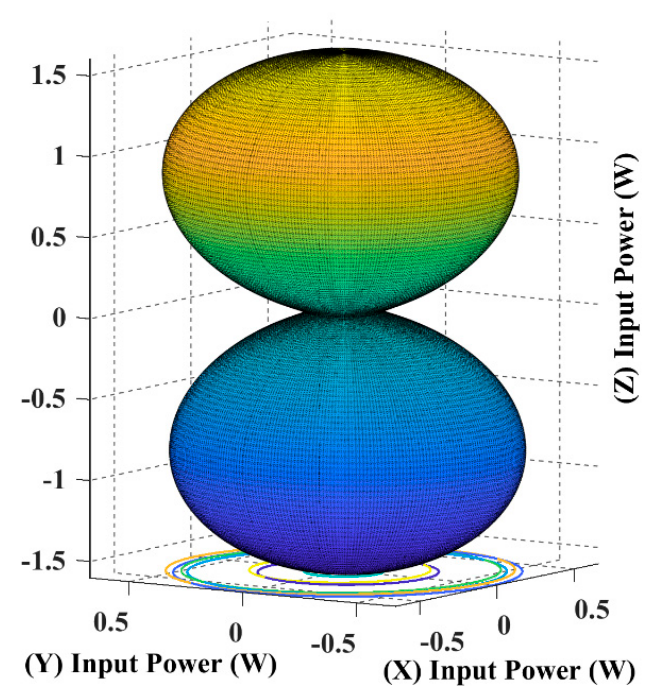
Figure 9. The input power spherical plot for the 3D WPT system when the receiver is placed at α = φ = 0°. From Figure 10, it is noticeable that when the receiver is placed at the 45 ◦ angular position, the power transfer reaches the maximum of 2.5 W towards the receiver direction. In this position, the receiver is coupled equally with the three transmitters, resulting in a significant rise in the input power.